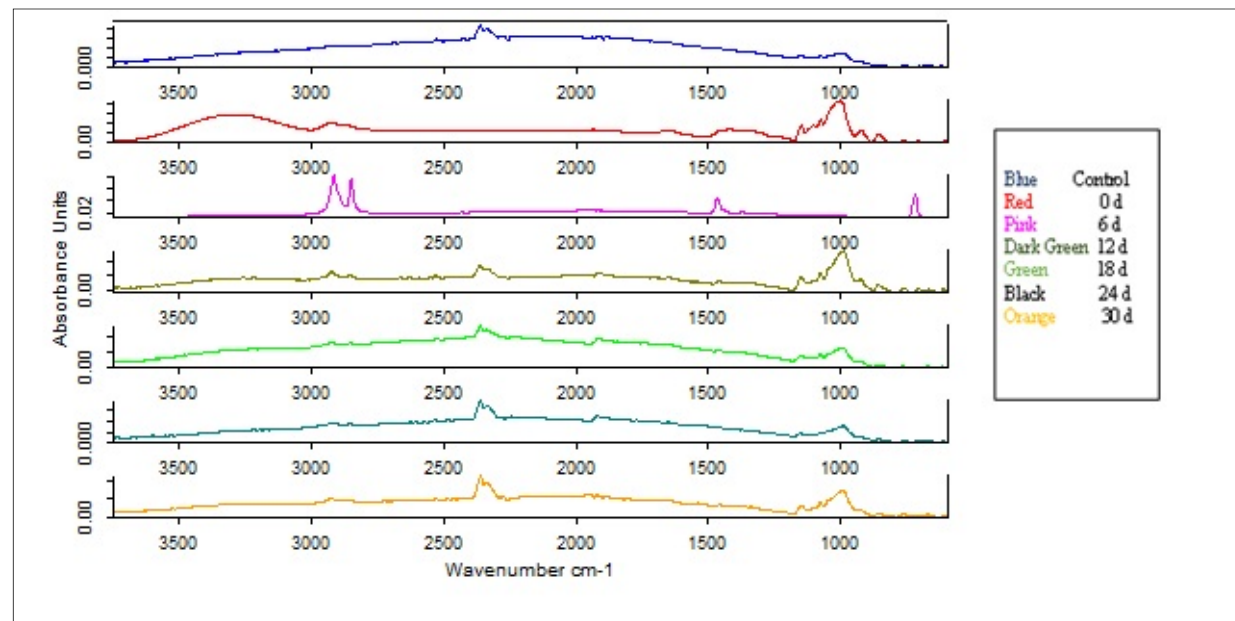
Figure 8. FTIR spectra of CSH film samples and control sample (Polyethylene film) before and during soil burial test.